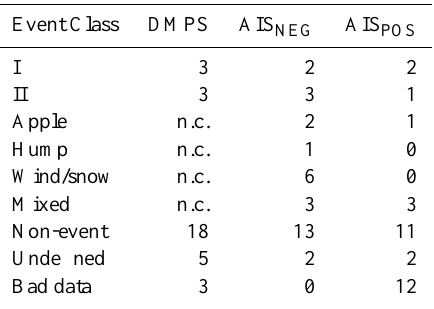
Table 4. New particle formation event classification between 29 December 2006–29 January 2007. The numbers refer to number of days of the total of 32 days. All types were not classified (n.c.) from DMPS data.